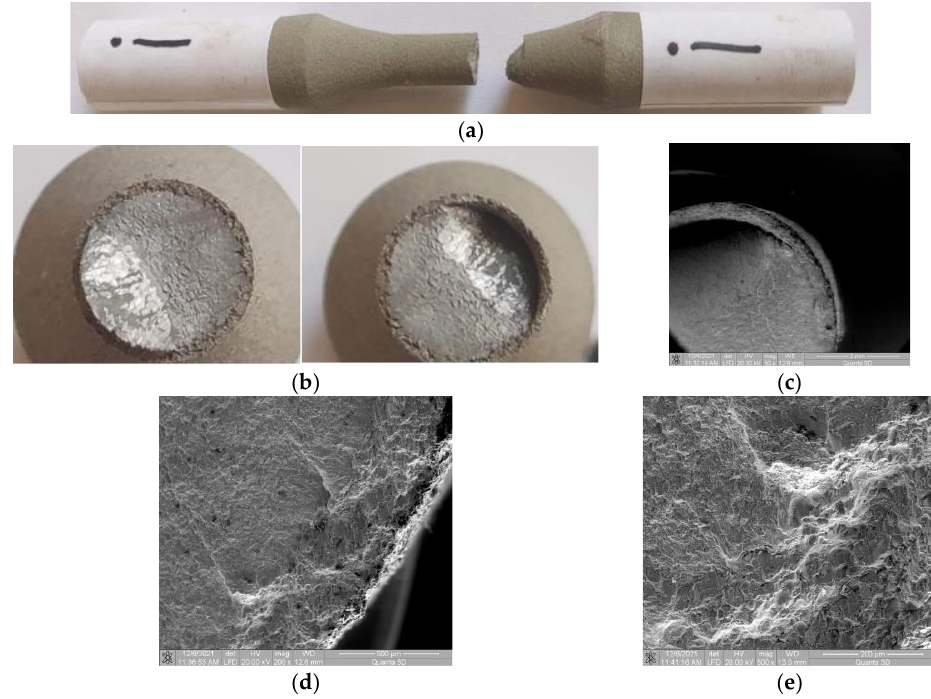
Figure 8. Macroscopic and microscopic images of broken surfaces for samples I and J. ( a ) Specimen I: Side view of the broken sample. ( b ) Specimen I: Macroscopic images of surfaces resulting from breakage. ( c ) Specimen I: SEM image (50×) of the broken surface at plane deflection. ( d ) Specimen I: SEM image (200×) of the interface area. ( e ) Specimen I: SEM image (500×) with damage in the interface area.